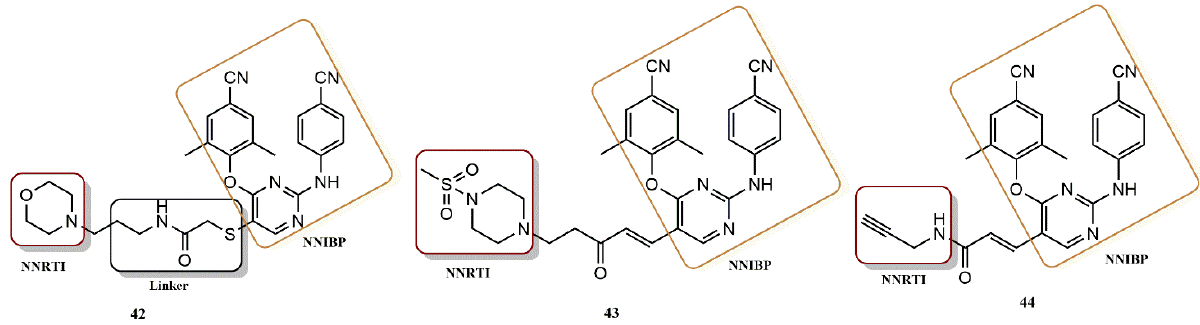
Figure 30. Dual RT pharmacophores of new active synthesized compounds 42 , 43 and 44 .